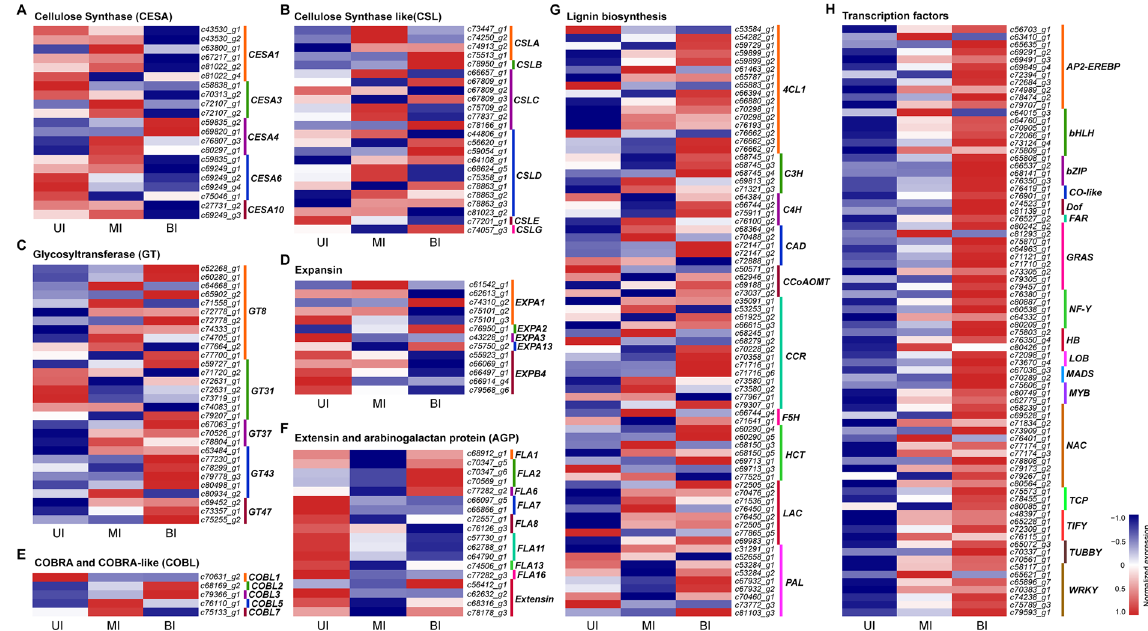
Figure 7. Expression profiles of cell wall biosynthesis genes and transcription factors during internode development. The heatmap was generated with Z-score normalized FPKM values. Up-regulated genes are shown in red, whilst down-regulated genes are in blue. ( A ) expression profiles of cellulose synthase genes. ( B ) expression patterns of cellulose synthase-like genes. ( C–F ) expression analysis of genes encoding cell wall structural proteins. ( G ) expression profiles of monolignol biosynthesis genes. ( H ) expression patterns of transcription factor genes. UI, upper internode, MI, middle internode, BI, basal